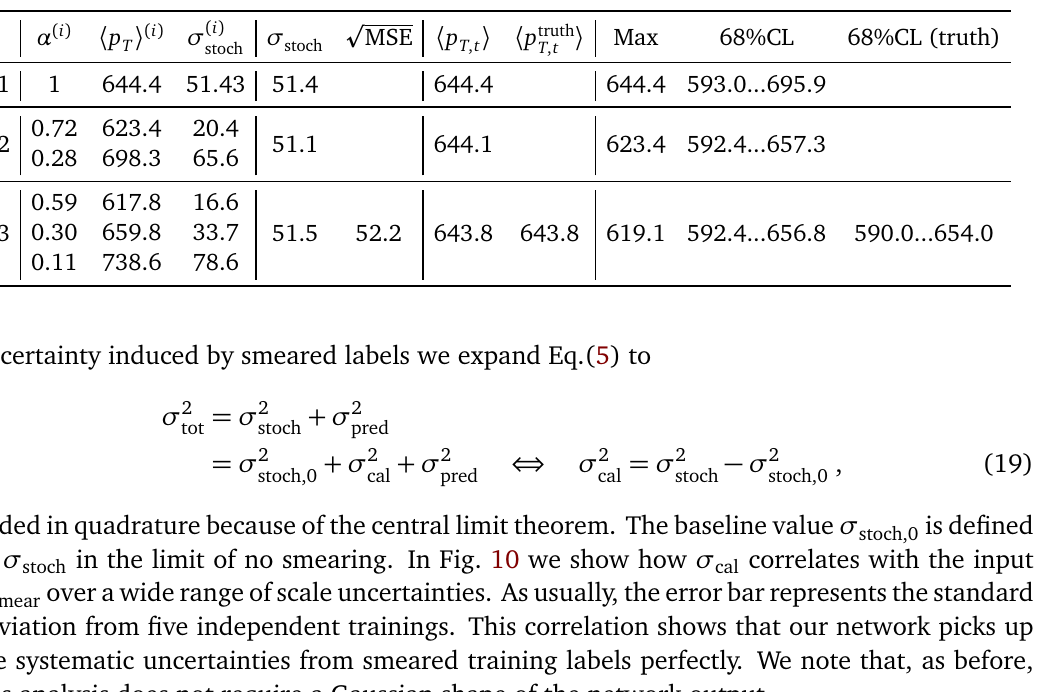
Table 2: Parameters used in Fig. 8, specifically p